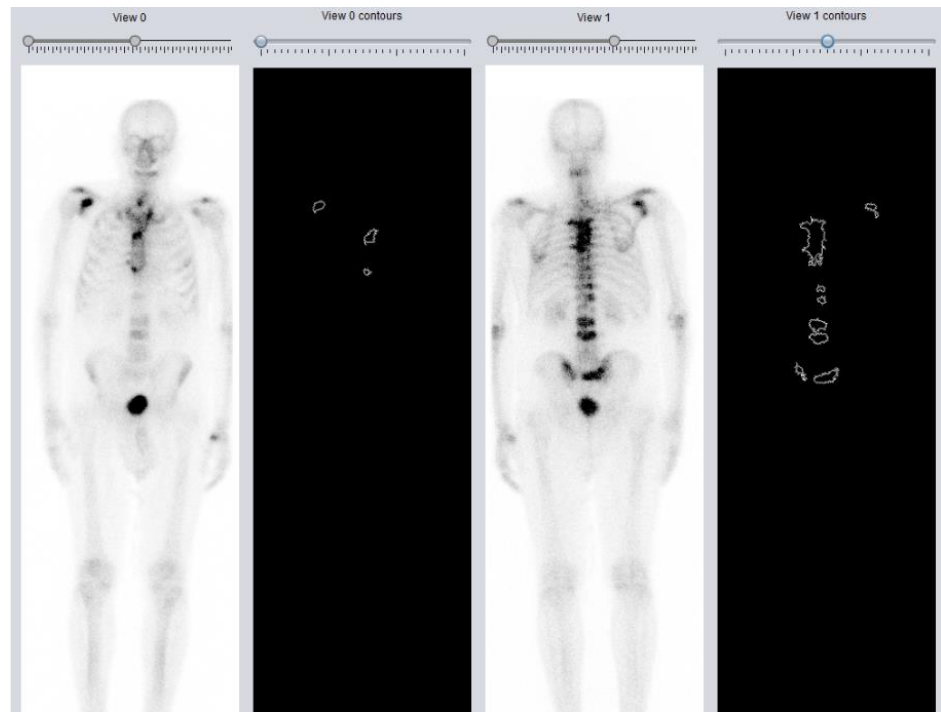
Figure 1. The 99mTc-HDP BS, an example of evaluation of the load of metastatic disease through DASciS software. BSI = 1.56%.